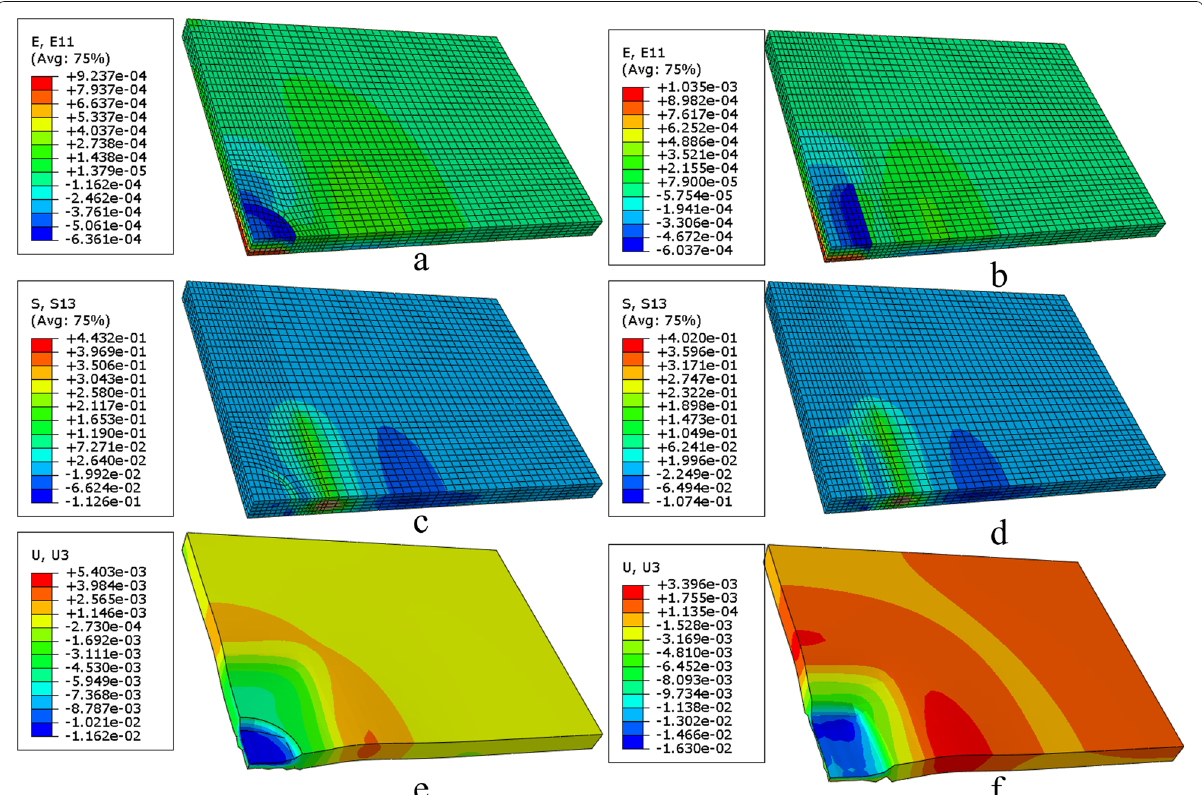
Fig. 8 Comparisons of circular and rectangular shape for small repairs, a and b are horizontal strain (E11) at 0.17s, c and d are shear stress (S13) at 0.17s, e and f are vertical deformation (U3) at